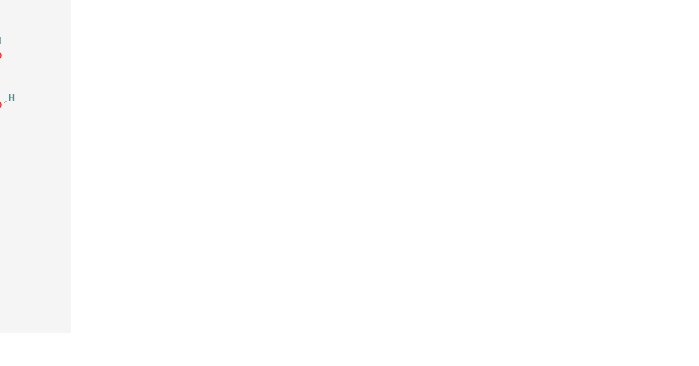
Figure 2. Chemical structure of the anthocyanin glycosides identified in the eggplant peel extracts: delphinidin 3- O -rutinoside-5-glucoside ( a ); delphinidin 3- O -glucoside ( b ); delphinidin 3- O -rutinoside ( c ); cyanidin 3- O -rutinoside ( d ), and petunidin 3- O -rutinoside ( e ). [26]. The anthocyanins from the eggplant peel extracts were identified based on the reten- tion time and by comparison with the available standards and existing data in the litera- ture. The identification wavelength was 520 nm. The chromatographic profile revealed the presence of five compounds: delphinidin 3- O -rutinoside-5-glucoside (Figure 3a), del- phinidin 3- O -glucoside (Figure 3b), delphinidin 3- O -rutinoside (Figure 3c), cyanidin 3- O - rutinoside (Figure 3d), and petunidin 3- O -rutinoside (Figure 3e). Three of the compounds were assessed based on the available standards, while the other two compounds were